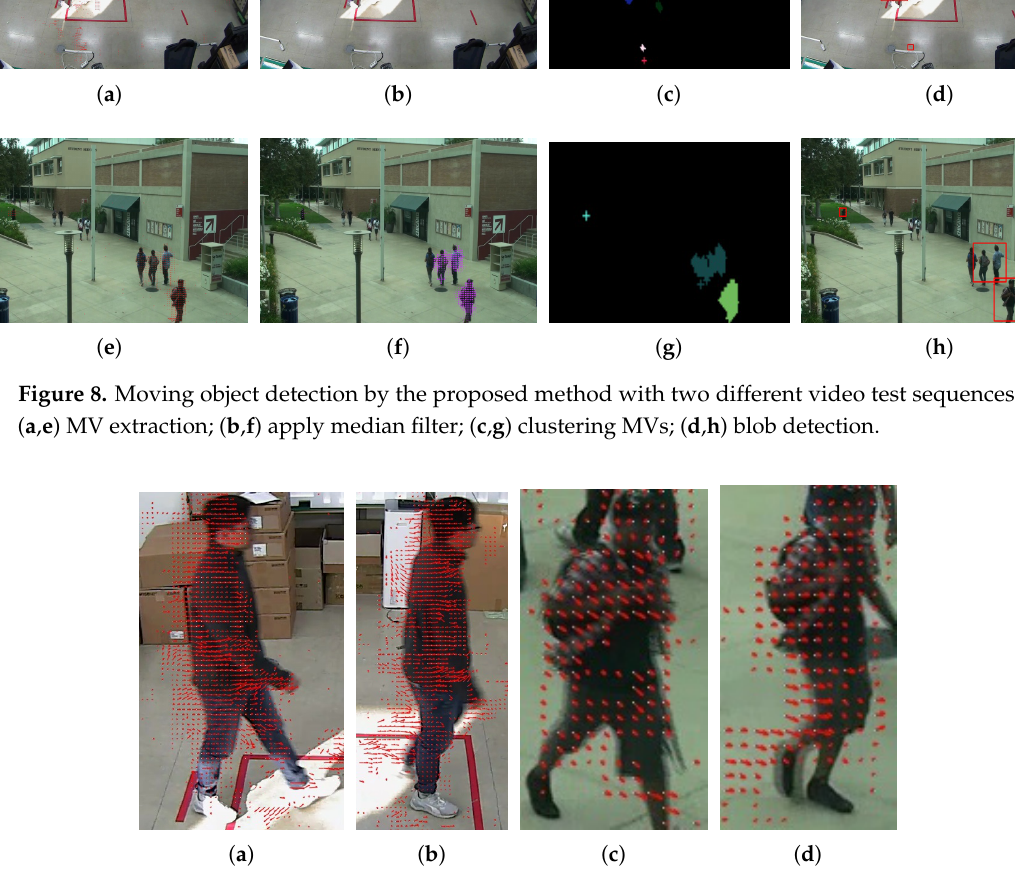
Figure 9. Motion vector of a moving object in different video test sequences: ( a , b ) our recorded video; ( c , d ) test video in